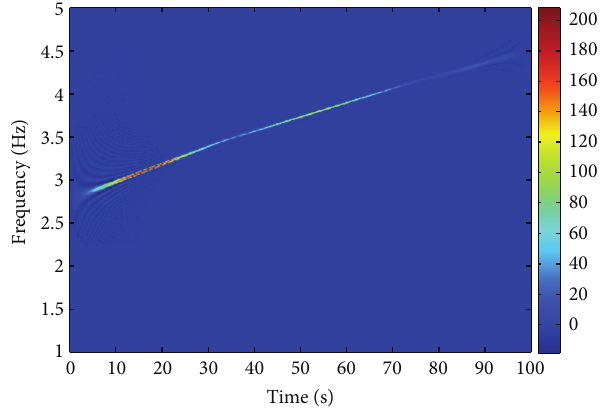
Figure 8: CT spectrogram of case 1.